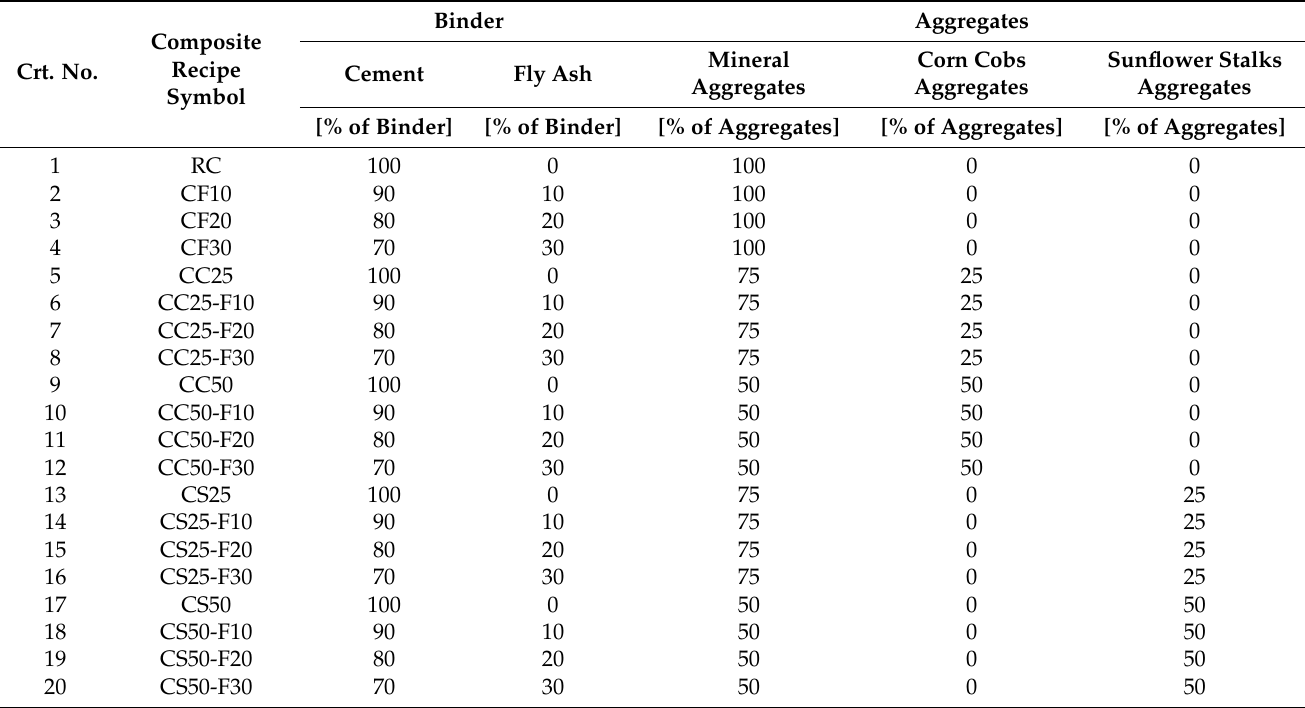
Table 2. Particular elements of the recipes developed and analyzed in the